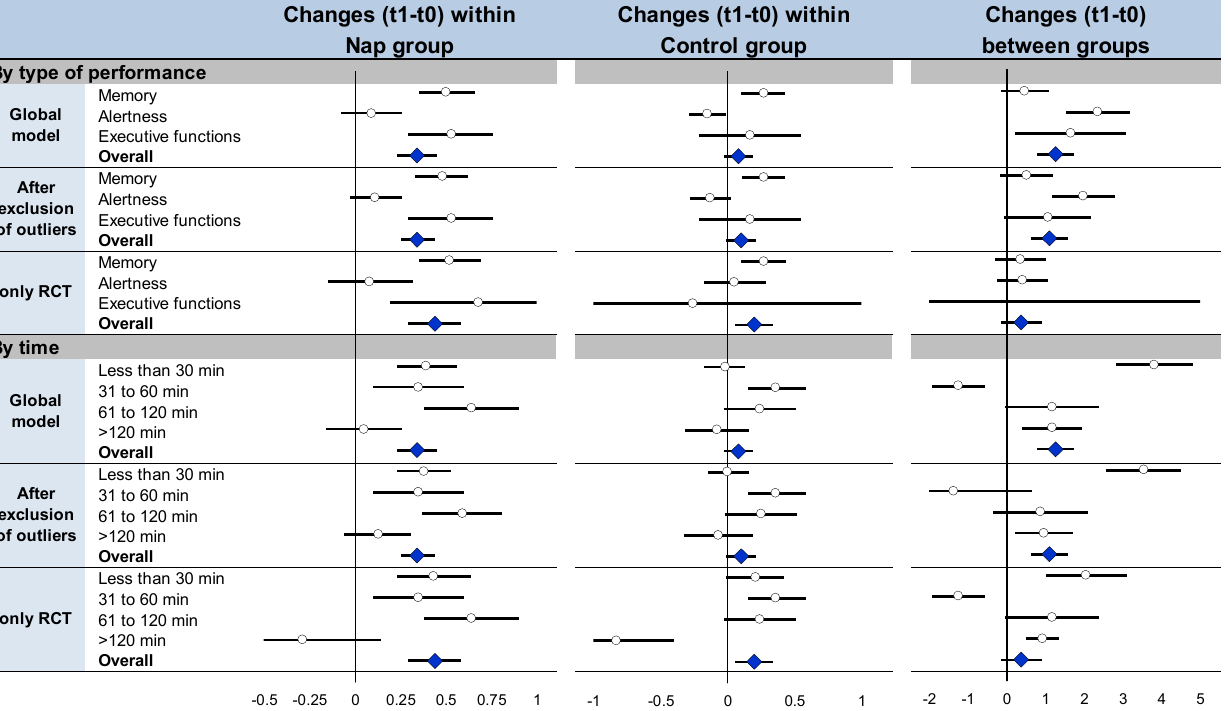
Figure 5. Summary of sensitivity analysis: meta-analyses on cognitive performance at t1 compared with baseline (t0) within the nap group ( left ), meta-analyses on cognitive performance at t1 compared with baseline (t0) within the control group ( middle ), meta-analyses on changes in performance between t1 and t0 ((t1 − t0)/t0) between nap and control groups ( right ) Each summary of meta-analysis is presented in three conditions: global model with all the studies, after exclusion of outliers (studies not evenly distributed around the funnel plot) and with only randomized controlled trials For details of each meta-analysis, please see Figures S4, S6 and S7. Each summary of several meta-analyses is represented in the forest-plot by a dot on a horizontal line. The black dots represent the pooled-effect estimate (pooled effect size—ES), and the length of each line around the dots represents their 95% confidence interval (95CI). Shorter lines represent a narrower 95CI thus higher precision around pooled-ES. Conversely, longer lines represent a wider 95CI and less precision around pooled-ES. An overall summary of the results of the meta-analyses pooled-estimate (result of the overall meta-analysis) is repre- sented by a blue lozenge at the end of the graph. The black solid vertical line represents the null estimate (with a value of 0 for pooled-ES). Horizontal lines that cross the null vertical line represent the non-significant overall summary of the meta-analysis.